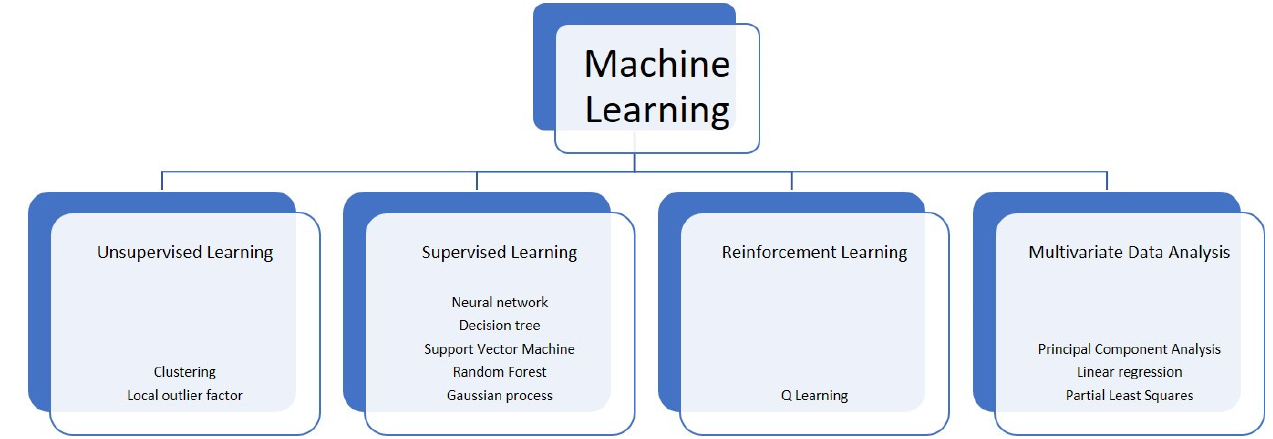
Figure 1. Some of the main computational techniques of machine